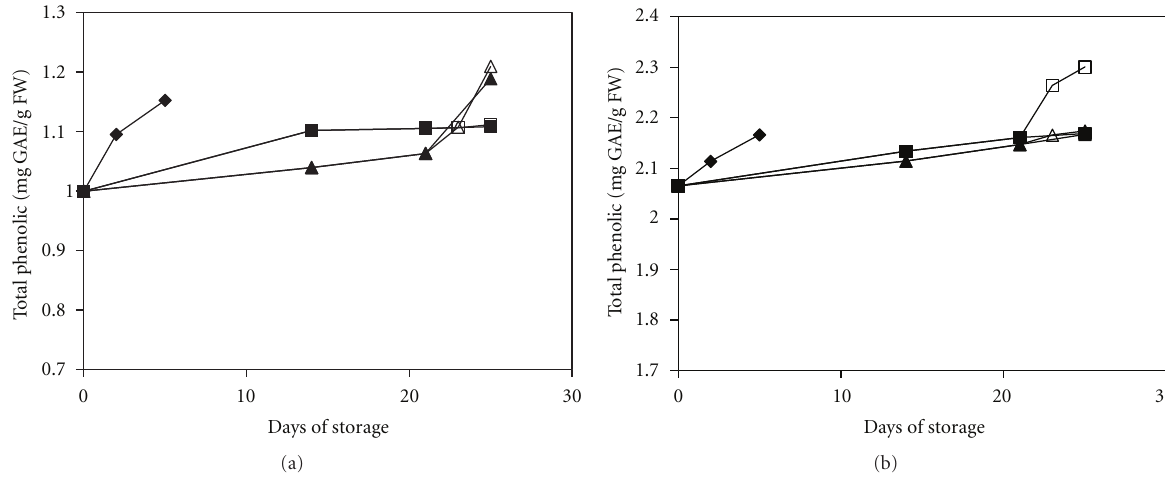
Figure 1: Changes in the total phenolic content of mature green peppers (a) and fully ripe/red peppers (b) for the UCRT ( (cid:2) ), MAP ( (cid:3) ), and MAP+1-MCP ( (cid:4) ) treatments during storage at 10 ◦ C; MAP ( (cid:5) ) and MAP+1-MCP ( (cid:6) ) values for the fruits transferred to room temperature at day 21. The values are the means of six replicate samples, and their S.E.s are indicated.